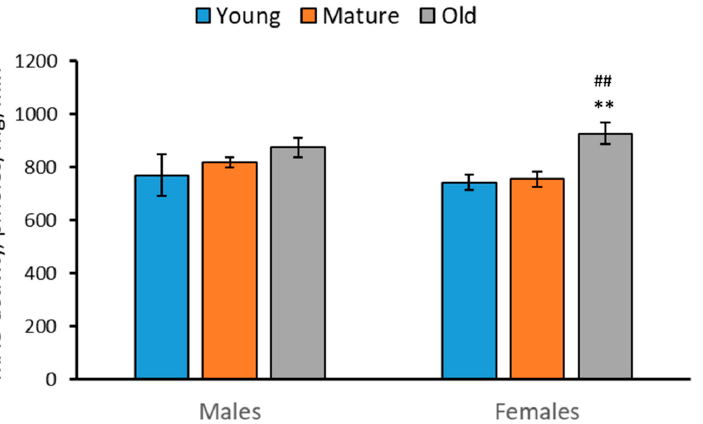
Figure 4. MAO activity in the brain of 2 (young)-, 4 (mature)- and 7 (old)-month-old males and females of N. furzeri . ** p < 0.01 vs. young females; ## p < 0.01 vs. mature females. 2.5. Correlations between the Levels of the 5-HT, 5-HIAA and 5-HIAA/5-HT Turnover Rate and TPHs and MAO Activities in the Brain of Male and Female N. furzeri Significant positive correlations between the TPH activity, the 5-HT and 5-HIAA levels in the brain of male and female N. furzeri were shown (Table 2). As expected, the 5-HIAA/5-HT turnover rate positively correlated with the 5-HIAA level and negatively correlated with the 5-HT level (Table 2). At the same time, no statistically significant correlation between the MAO activity on one hand and the 5-HT and 5-HIAA levels and the 5-HIAA/5-HT turnover rate on the other hand in the brain of males and females of N. furzeri was found (Table 2).